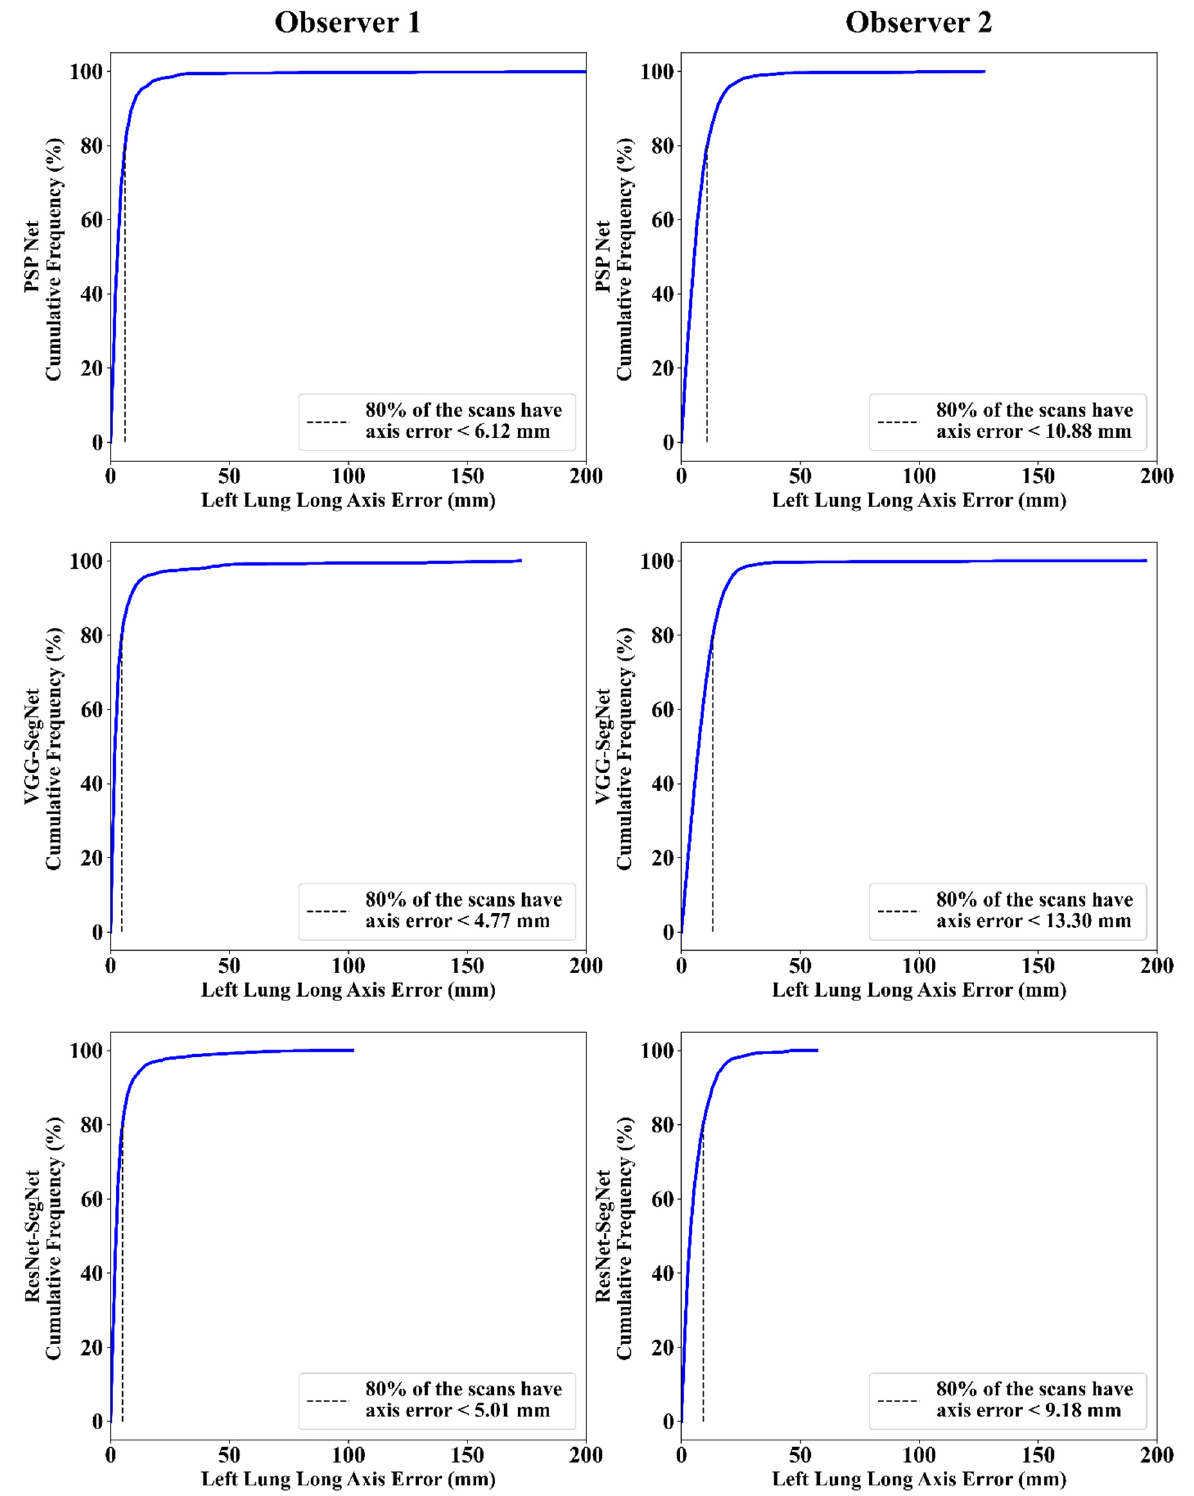
Figure 21. Cumulative frequency plot for left LLAE using three AI models: Observer 1 vs. Observer 2.